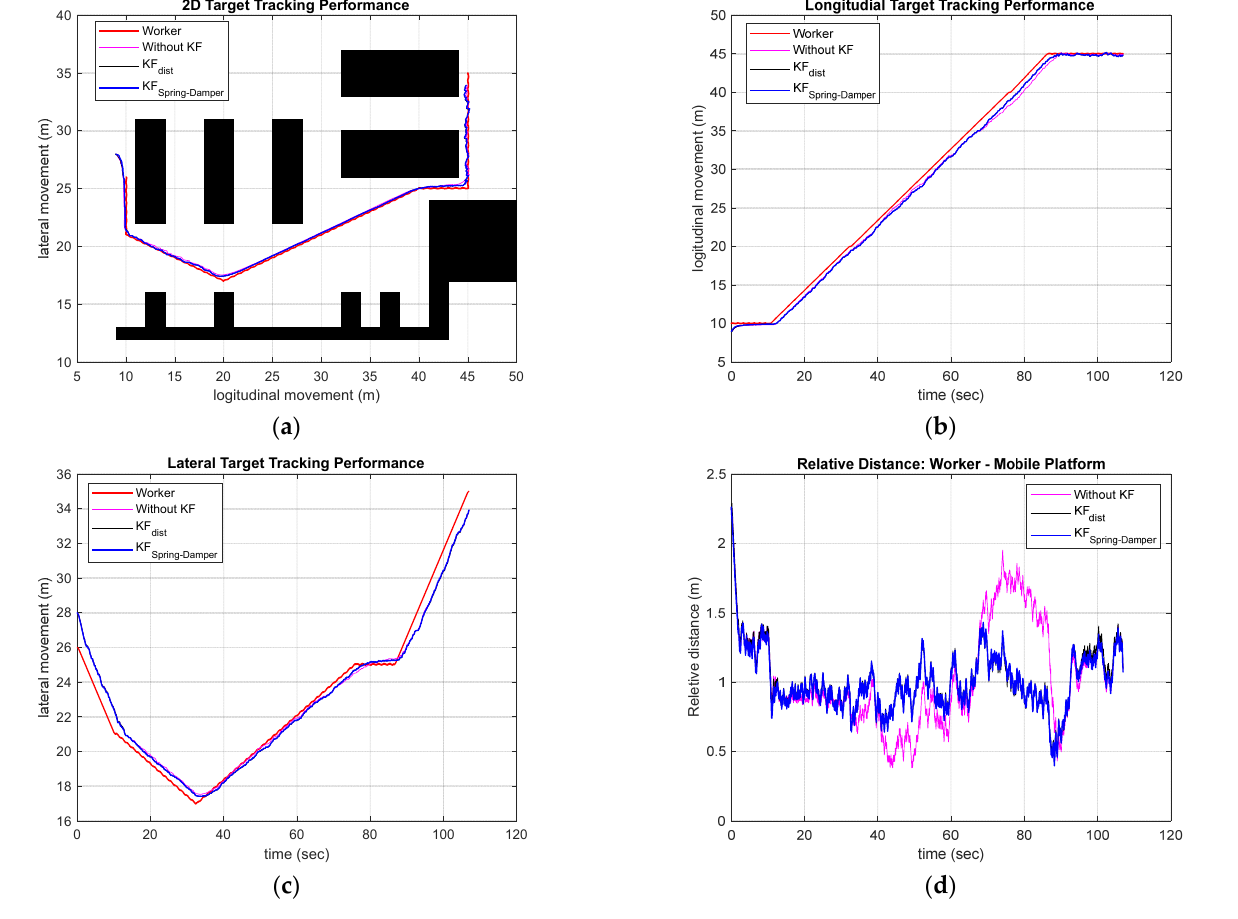
Figure 12. Worker-following performance: ( a ) 2D plane worker-following performance ( b ) Longi- tudinal direction performance ( c ) Lateral direction performance ( d ) Target tracking performance (relative distance).